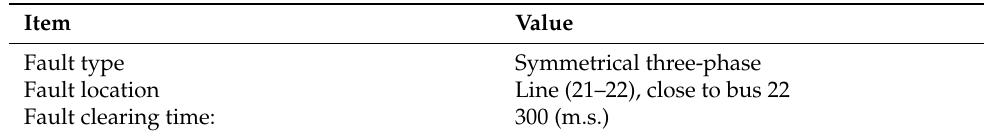
Table 2. Characteristics of the considered fault.